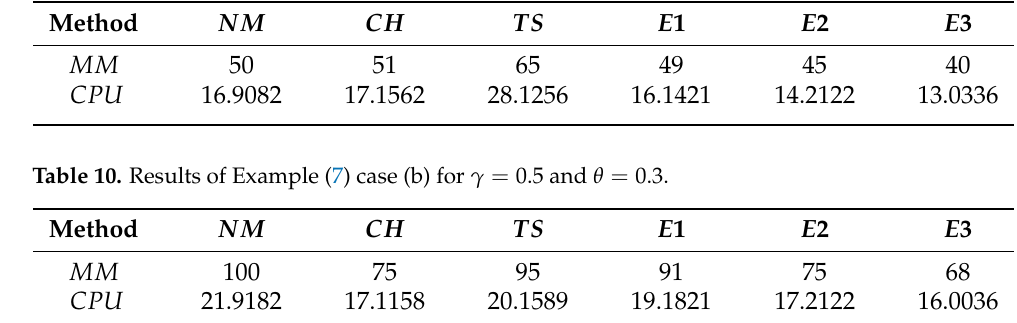
Figure 10. Representation of the ( a ) matrix and ( b ) inverse matrix for Example (7) case ( b ), when p = q = 15, respectively. Table 9. Results of Example (7) (a) for γ = θ = 0.2.